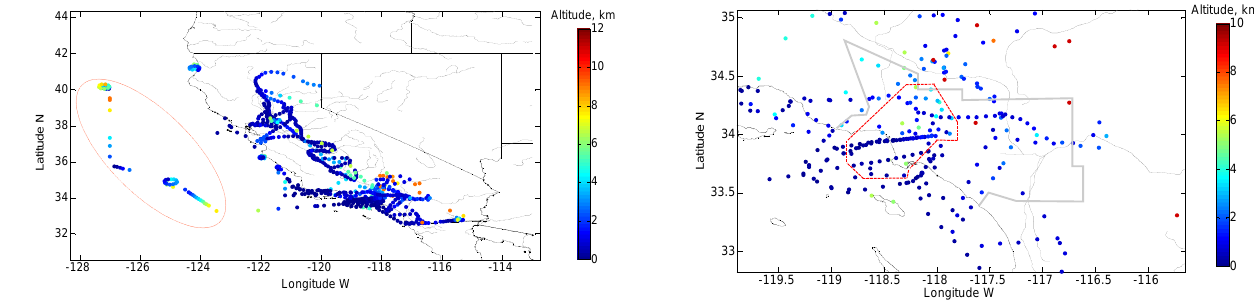
Figure 1. Geographic distribution of samples collected during the four ARCTAS-CARB Fig. 1. Geographic distribution of samples collected during the four flights and two transit flights. The samples are color-coded by altitude. The dotted red oval ARCTAS-CARB flights and two transit flights. The samples are highlights part of the samples collected during Flight 14, which are used to characterize the color-coded by altitude. The dotted red oval highlights part of the inflow air. samples collected during Flight 14, which are used to characterize the inflow air.